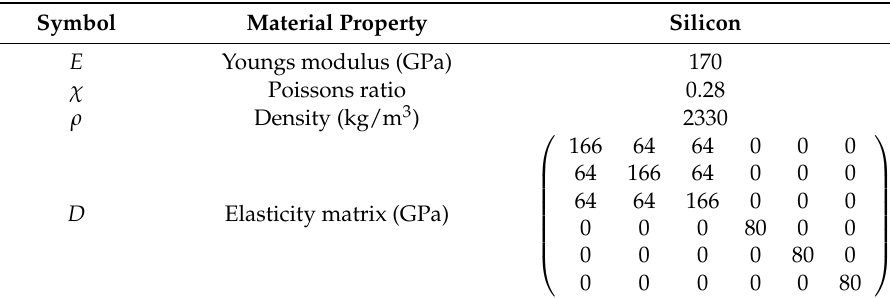
Figure 5. First principle stress on average over a piezo-resistive strut ( a ) vs. strut position along the cantilever length and ( b ) vs. strut width with strut/cantilever thickness as the parameter to the curves.